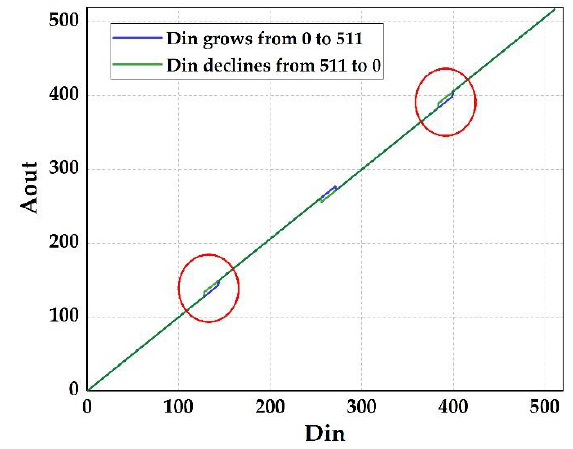
Figure 6. The conversion characteristic of non-ideal 10-bit DAC based on proposed algorithm.